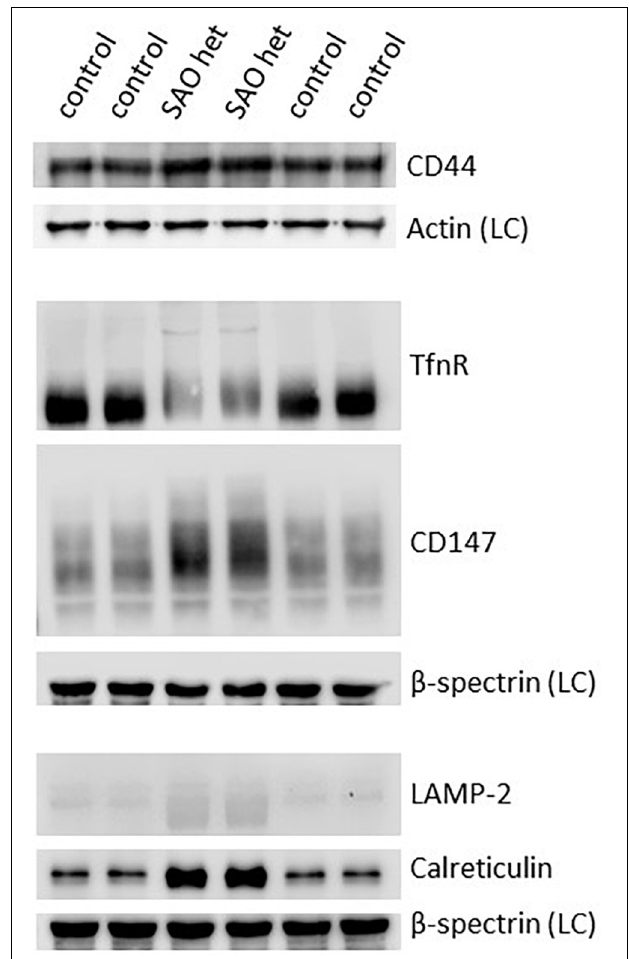
FIGURE 11 | Expression of membrane proteins involved in reticulocyte maturation. Red cell membranes from heterozygous SAO and control peripheral blood samples were prepared, separated by SDS-PAGE and immunoblotted. The antibody directed against CD44 was an in-house rabbit polyclonal antibody. Commercial antibodies were used to detect actin (ab6276), calreticulin (ab2907); CD147 (ab108308), LAMP-2 (ab25631) and transferrin receptor (TfnR) (ab84036); all from Abcam, Cambridge, United Kingdom. An in-house monoclonal antibody was used to